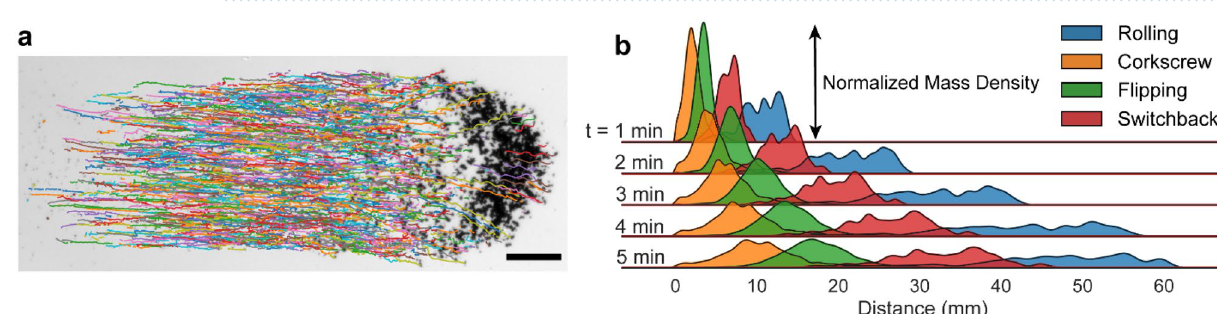
Figure 4. Spreading of µwheel swarms. ( a ) Sample trajectory tracking in a flipping swarm after 20 s. Scale = 300 µm. ( b ) Predicted mass transport of swarms based on measured velocity distributions. The shaded area under each curve is